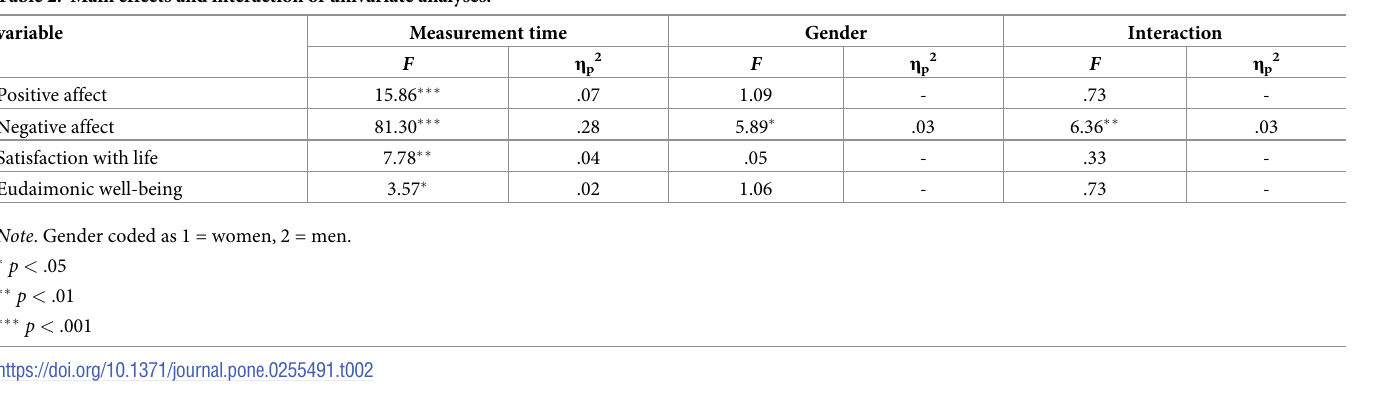
Table 2. Main effects and interaction of univariate